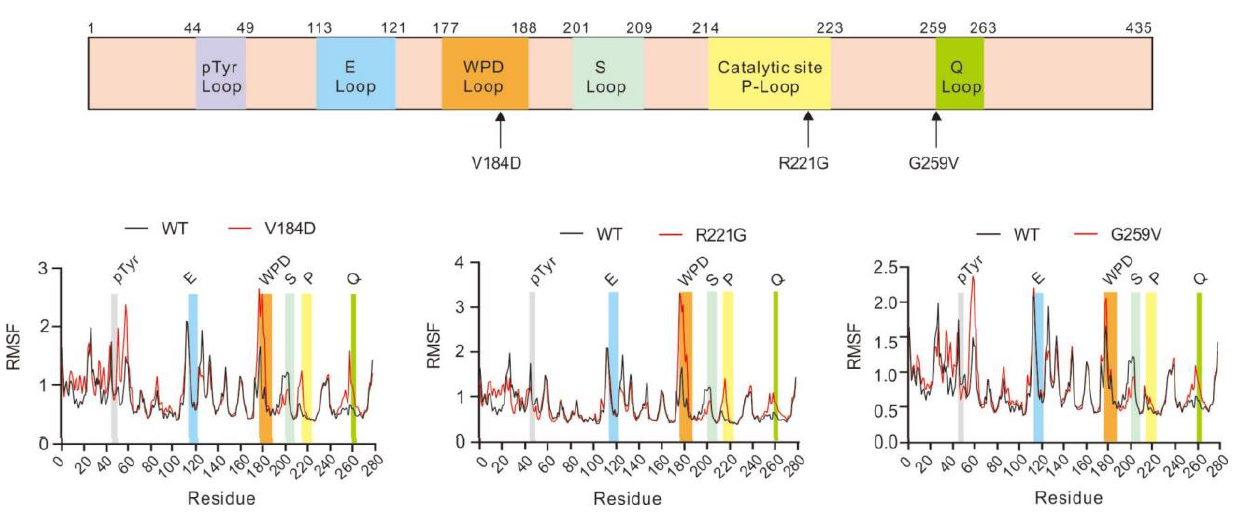
Figure 5. Molecular dynamic simulations of PTP1B in the WT and mutants and the impact on the active site loops. Upper panel: Schematic representation of the different key loops of PTP1B (residues 1–435; pTyr-loop is shown in purple, E-loop in blue, WPD-loop in orange, S-loop in light green, catalytic P-loop in yellow, and Q-loop in green). Lower panel: Molecular dynamics simulations of the PTP1B proteins (100 ns simulations) in the WT and mutants using Amber20 software. Data were extracted with VMD and presented as RMSF. Differences between PTP1B in the WT and mutants were highlighted according to the loop color scheme defined in the upper panel.